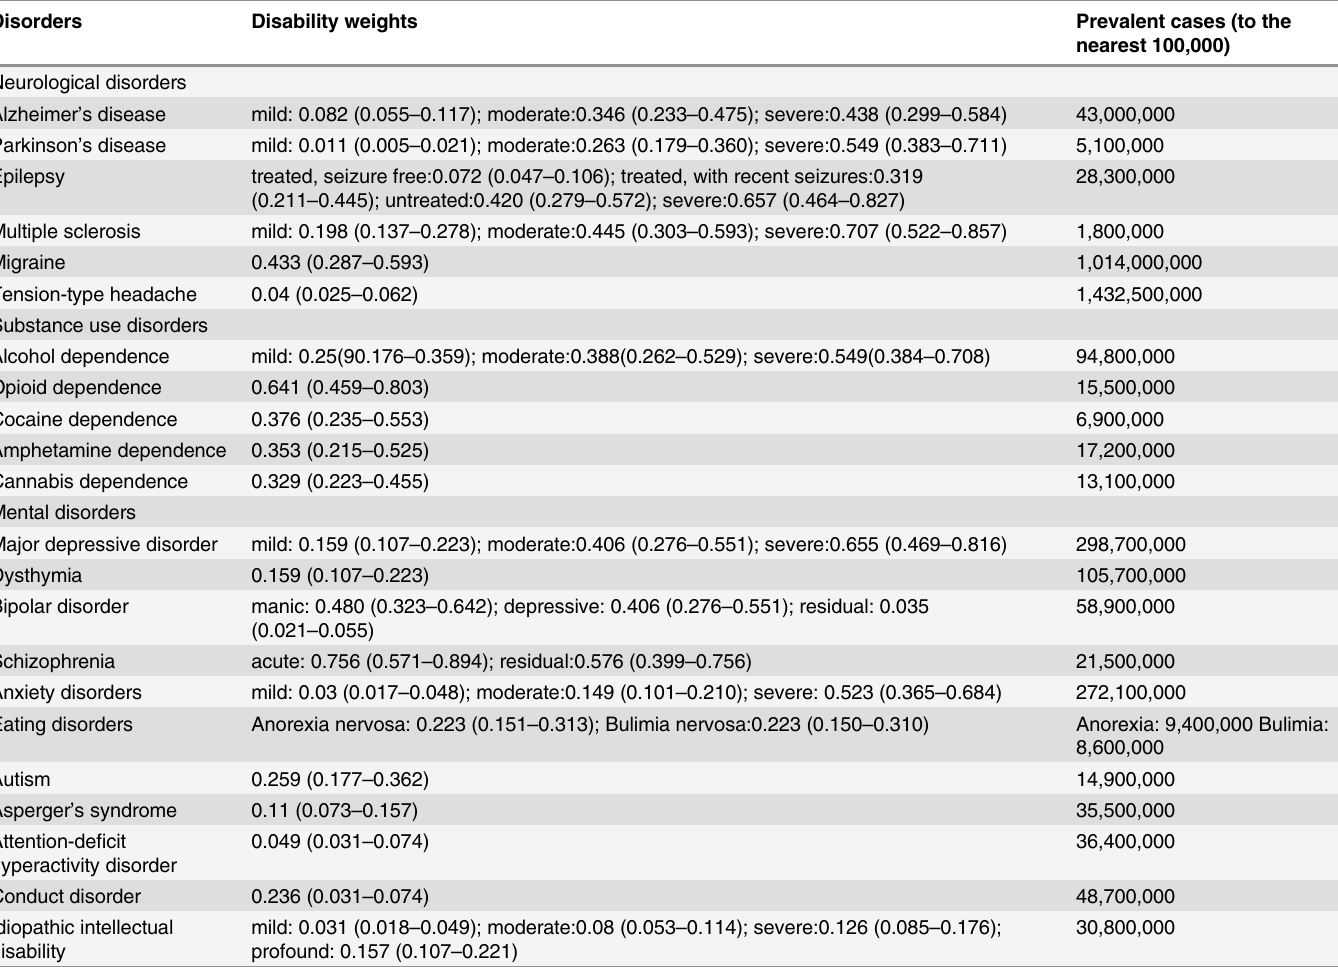
Table 1. GBD 2010 Mental, Neurological, and Substance Use Disorders, Estimated Disability Weights, and Prevalent